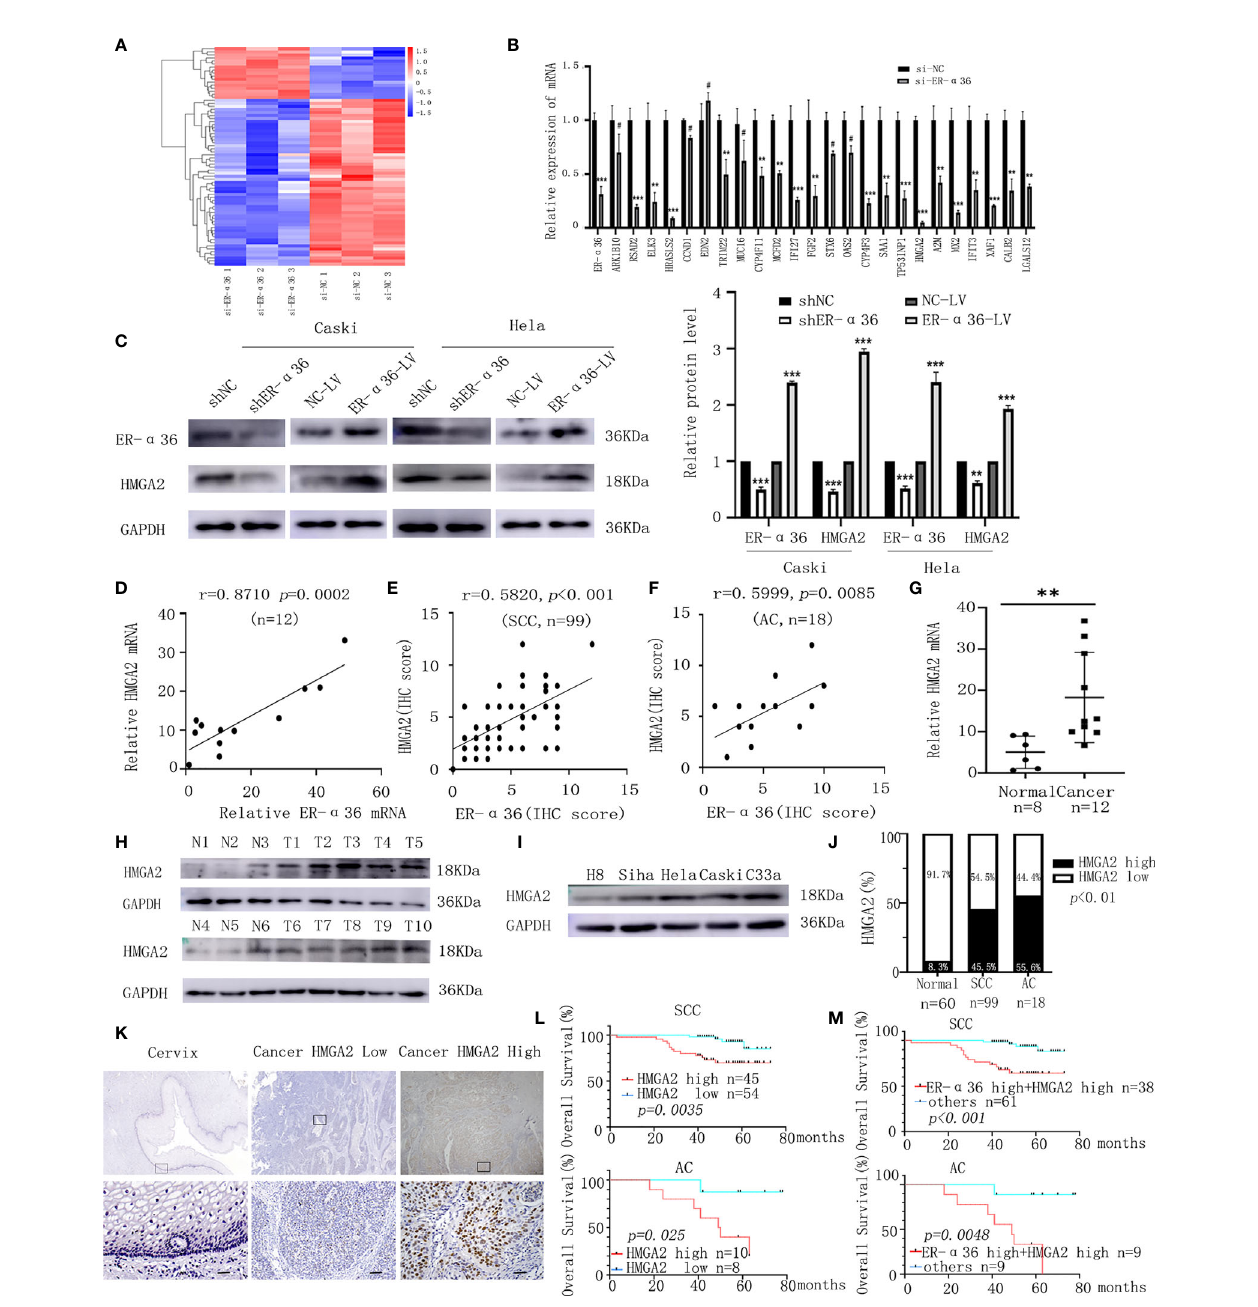
FIGURE 6 | HMGA2 is a downstream target of ER- a 36 in CC, elevated HMGA2 predicts unfavorable prognosis in patients with CC. Caski cells transfected with si- ER- a 36 and si-NC were treated by 1nM E 2 for 24 hours in next-generation sequencing (NGS) assay. (A) Heatmap of differentially expressed genes pro fi les in caski cells transfected with si-ER- a 36 and si-NC (High and low expression levels are indicated by red and blue, respectively). (B) The mRNA levels of top 24 downregulated genes in caski cells with ER- a 36 knockdown were detected by qRT-PCR. (C) Western blotting analysis of HMGA2 protein expression after ER- a 36 knockdown and overexpression. (D) Correlation analysis between ER- a 36 and HMGA2 expression in fresh-frozen CC tissues. (E, F) Association of IHC scores between ER- a 36 and HMGA2 in cervical SCC and cervical AC tissues. (G) The mRNA level of HMGA2 in normal cervical tissues and CC tissues. (H) The protein level of HMGA2 in CC tissues(T1-T10) and normal cervical tissues(N1-N6). (I) The protein levels of HMGA2 in H8, siha, hela, caski and C33a cell lines. (J) The high and low expression rate of HMGA2 in 60 normal cervical tissues, 99 cervical SCC tissues and 18 cervical AC tissues. (K) Representative images of IHC staining of HMGA2 in CC tissues and normal cervical tissues (upper, ×40; lower, ×400, Scale bar: 50 µm). (L) Elevated HMGA2 expression correlates with the poor prognosis in cervical SCC patients and cervical AC patients. (M) Overall survival curves for cervical SCC patients and cervical AC patients were strati fi ed according to patients with high expression of ER- a 36 and HMGA2, and other patients. ( # p>0.05, **p < 0.01,